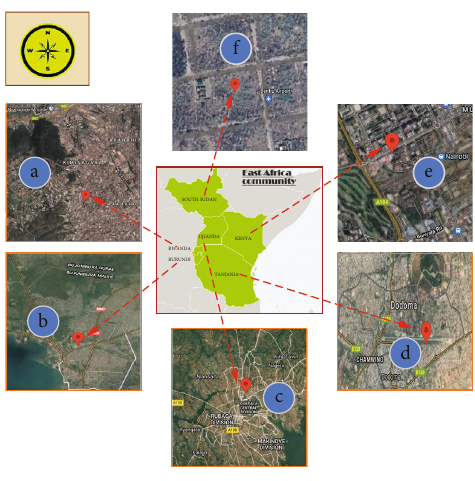
Figure 2: A map that depicts di ff erent selected sites in the East African Community countries: (a) is the Kimisagara National Road, Kigali, Rwanda (1 ° 57.2 ′ S, 30 ° 2.8 ′ E); (b) is the Chaussee de L ’ Agriculture, Bujumbura, Burundi (3 ° 21.7 ′ S, 29 ° 21.5 ′ E); (c) is the 2 Mulago III 2662, Kampala, Uganda (0 ° 20.8 ′ N, 32 ° 34.9 ′ E); (d) is the Unnamed Road, Dodoma, Tanzania (6 ° 10.3 ′ S, 35 ° 45.6 ′ E); (e) is the Times Tower, Nairobi, Kenya (1 ° 17.5 ′ S, 36 ° 49.4 ′ E); while the Bentiu, South Sudan (9 ° 13.9 ′ N, 29 ° 48.0 ′ E) is shown in South Sudan; and at Chaussee de L ’ Agriculture, Bujumbura, Burundi (3 ° 21.7 ′ S, 29 ° 21.5 ′ E), for Burundi. The luxury